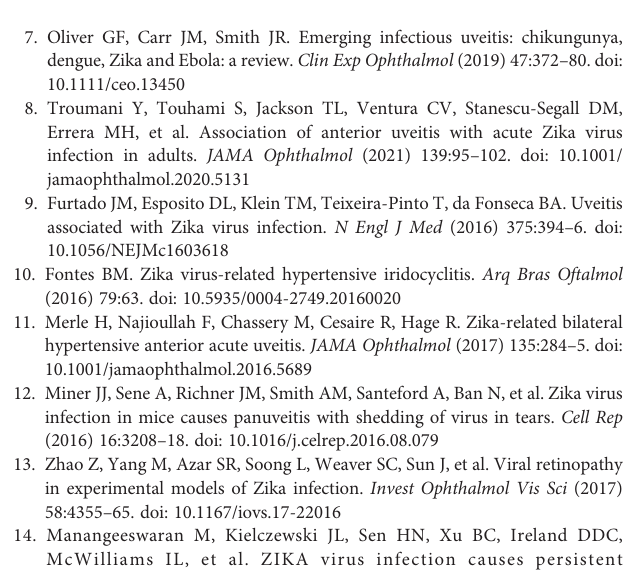
Supplementary Figure 1 | Bar plot showing composition of ZIKV-infected and uninfected human iris pigment epithelial cell samples, as classi fi ed by Kranken2 (30) against the GRCh38 human genome and the NCBI RefSeq database of bacterial, archaeal, viral and eukaryotic microbial genomes. Supplementary Table 1 | Alignment Statistics. Supplementary Table 2 | Differential Expression Analysis. Supplementary Table 3 | Enrichment Analysis. Supplementary Table 4 | Network Analysis. Supplementary Table 5 | Correlation